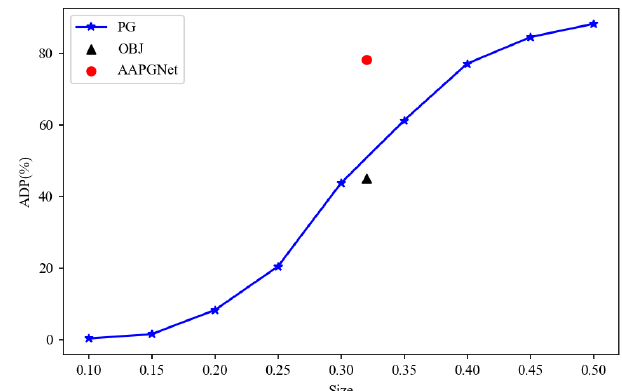
Figure 7. Performance comparison of the attacking algorithms. In this figure, for PG algorithm, we varied the patch size from 0.1 to 0.5 in the paper and presented it as a reference for readers. In Figure 7, the size represents the proportion of the patch size to the object